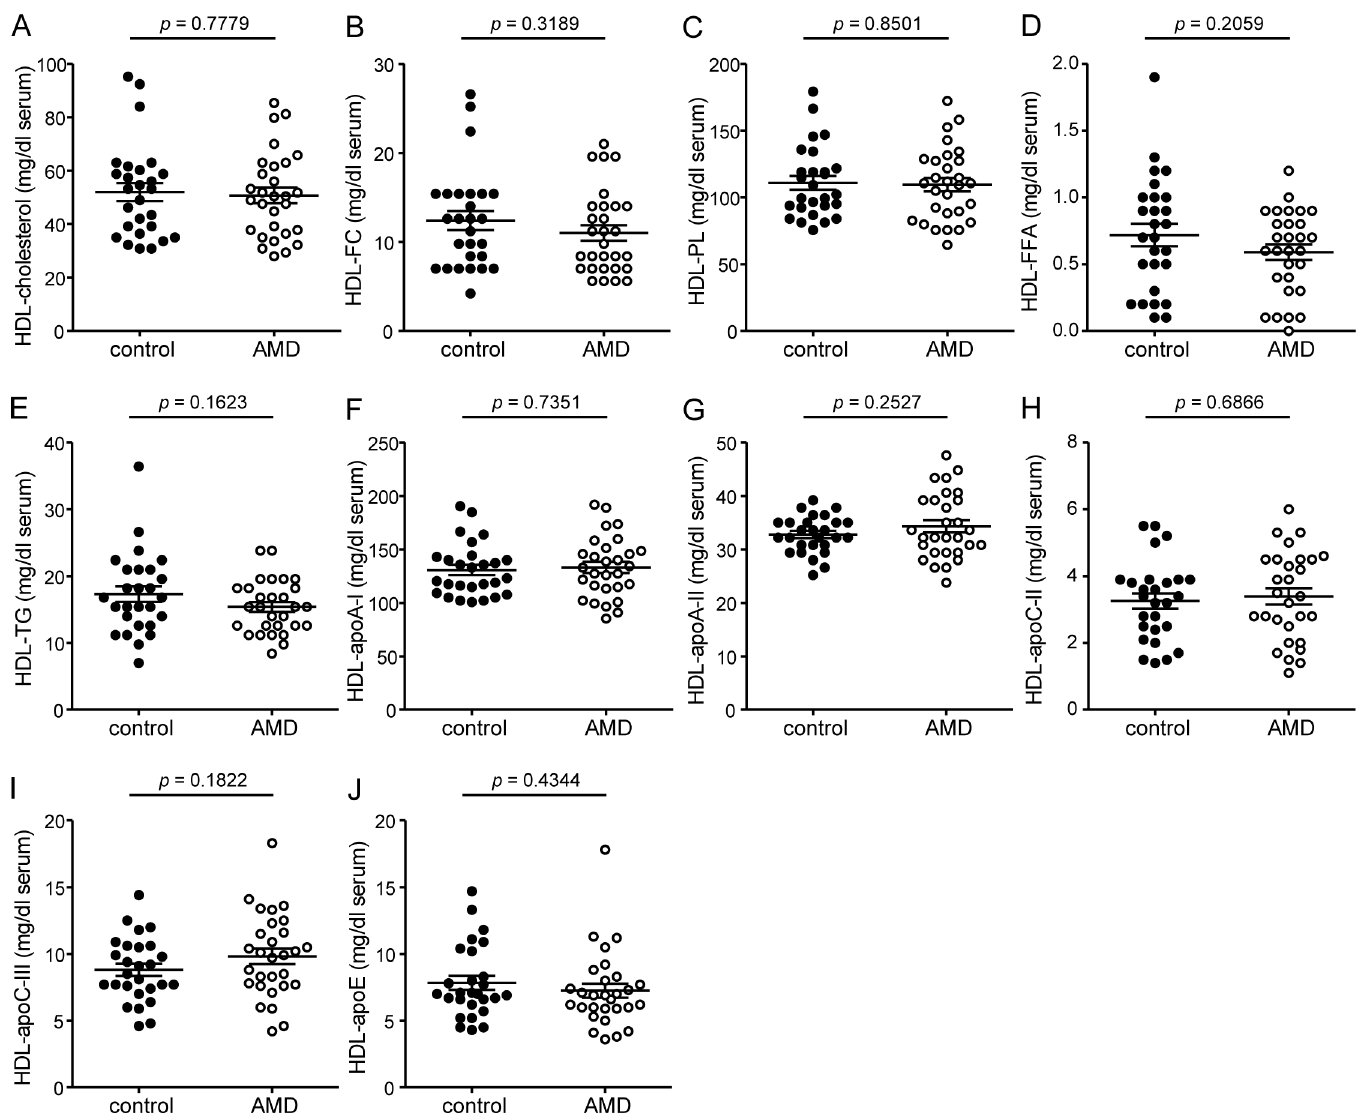
Fig 1. HDL-apolipoproteins and HDL associated lipids. Levels of total cholesterol (A), non-esterified cholesterol (FC) (B), phospholipids (PL) (C), free fatty acids (FFA) (D), triglycerides (TG) (E) were measured enzymatically in apoB depleted serum. HDL associated apolipoproteins ApoA-I (F), apoA-II (G), apoC-II (H), apoC-III (I) and apoE (J) were determined in apoB-depleted serum by immunoturbidimetry.